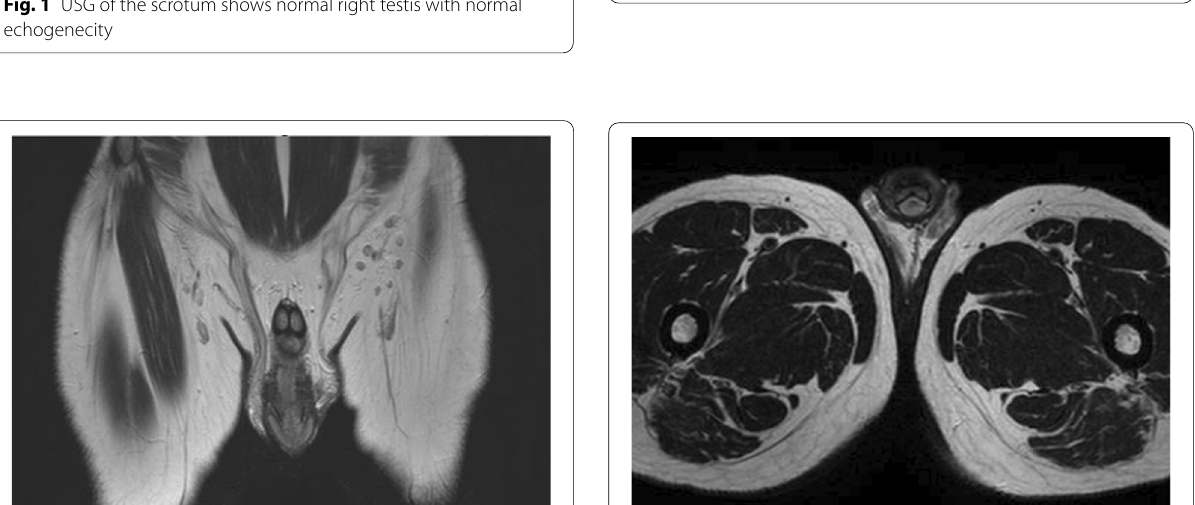
Fig. 4 MRI axial T2 weighted image shows right normal testis in the right scrotal sac